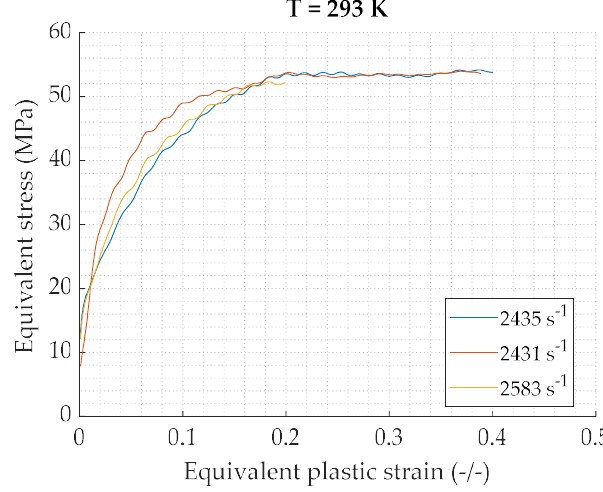
Figure 13. Three identical samples tested in dynamic compression with the same striker velocity.